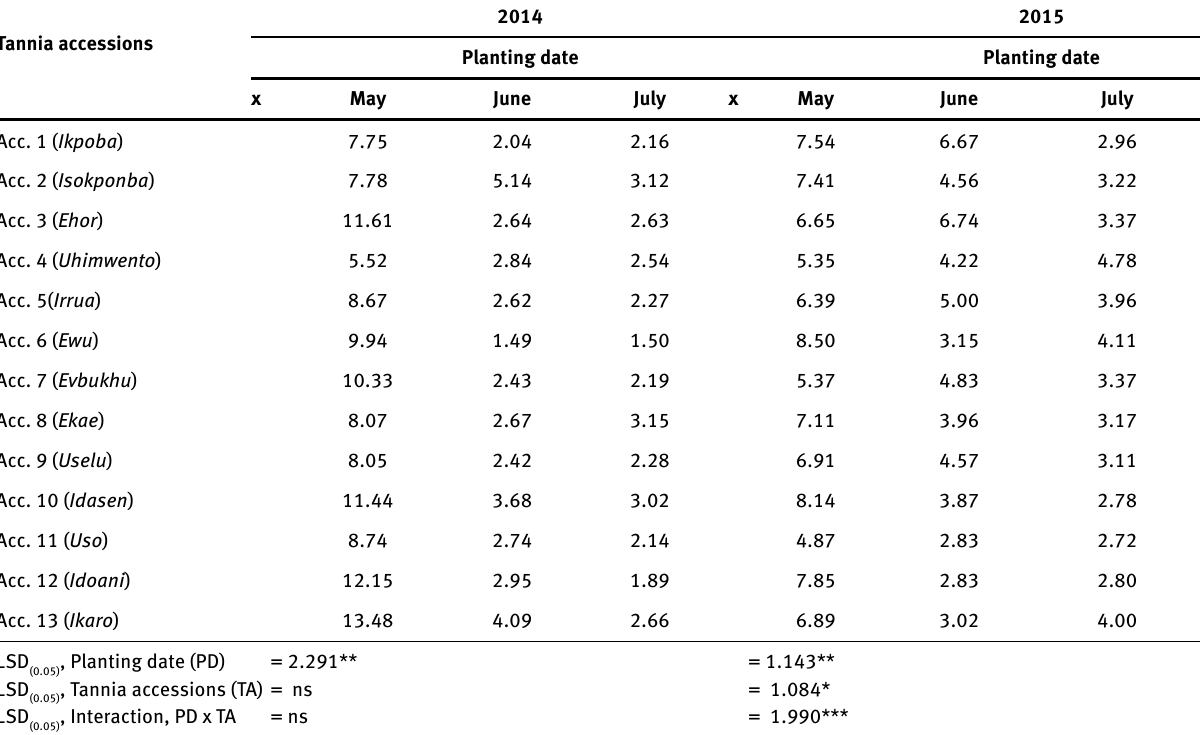
Table 8: Effect of interaction between planting date and tannia accessions on yield (Mt·ha) of tannia accessions in 2014 and 2015 cropping